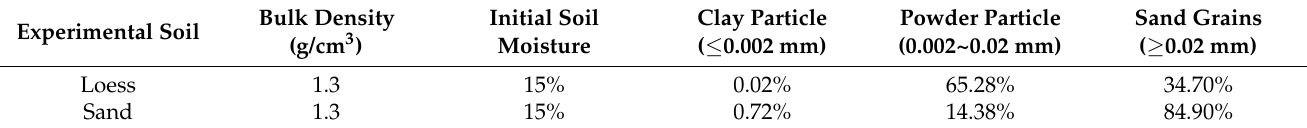
Table 1. Soil particle characteristics of test soil.